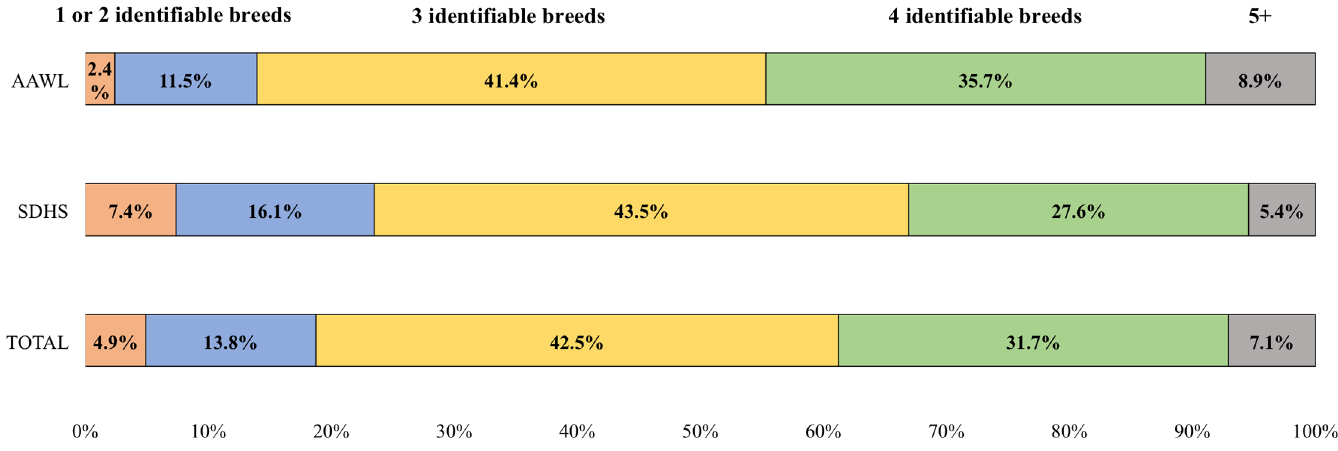
Fig 1. Proportion of dogs by number of identifiable breeds within its breed heritage.